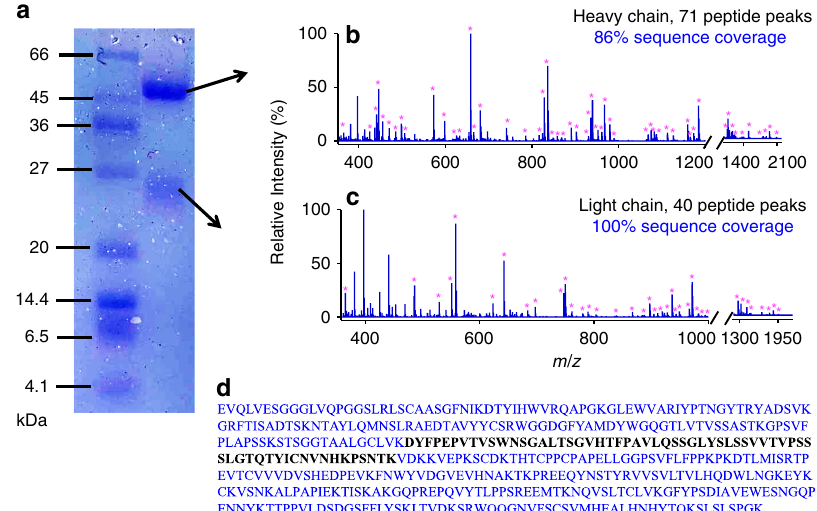
Fig. 7 Trypsin microdroplet digestion of the therapeutic antibody trastuzumab with ESSI-MS ( − 3 kV) after PAGE gel separation. a PAGE gel showing the protein ladder, antibody ’ s light and heavy chain bands stained with Coomassie blue. Mass spectra showing the microdroplet digestion of b light chain and c heavy chain. d The heavy chain of trastuzumab, with the covered sequence marked in blue and the uncovered sequence in black. Magenta asterisks denote the peptide fragments. Table 1 Comparisons of various techniques for accelerated protein digestion 68